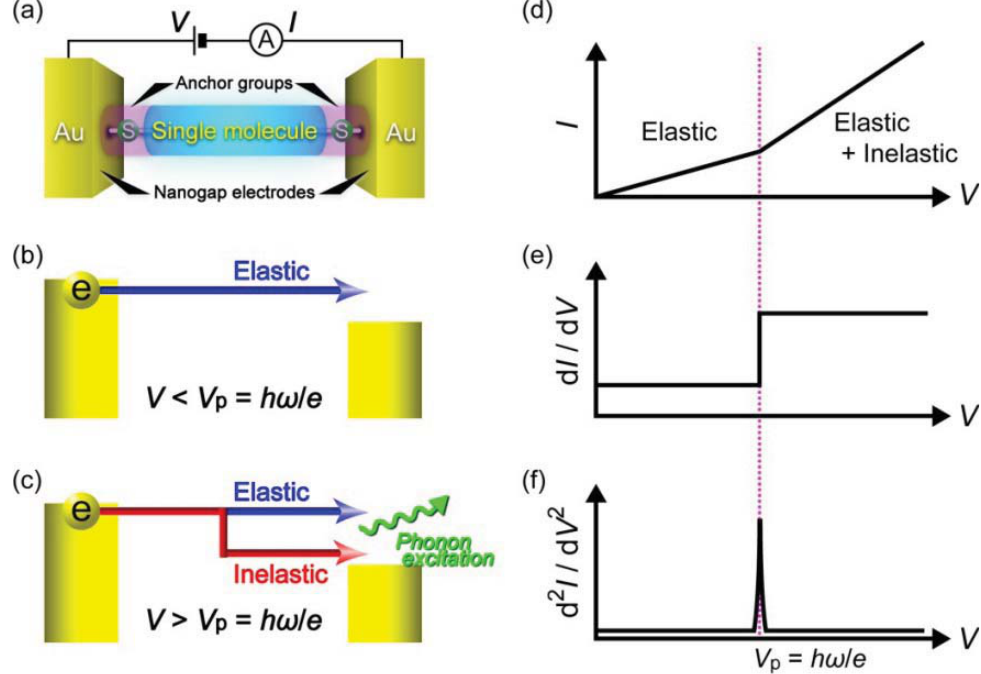
Figure 5. Inelastic electron tunneling spectroscopy for single-molecule fingerprinting. ( a , b ) Electrons tunnel through the molecule elastically at the low voltage; ( c ) When V exceeds V , a few per cent of the tunneling electrons couple strongly with a certain vibrational mode p with energy h(cid:6) , where (cid:6) is the molecular vibration frequency; ( d ) Current I flowing through a single-molecule tunneling junction increases linearly with the bias voltage V in the elastic tunneling regime; ( e ) At V > V , the inelastic channel opens and the p